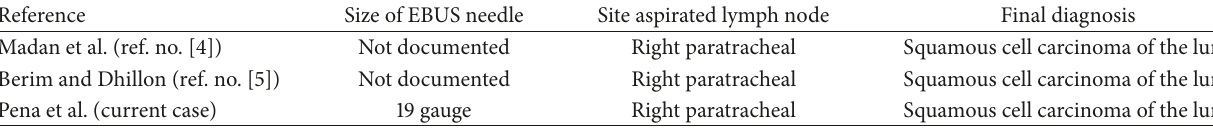
Table 1: Comparison of reported cases of malignancy in purulent aspirate of